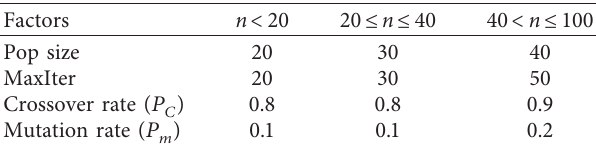
Table 5: Parameters used in